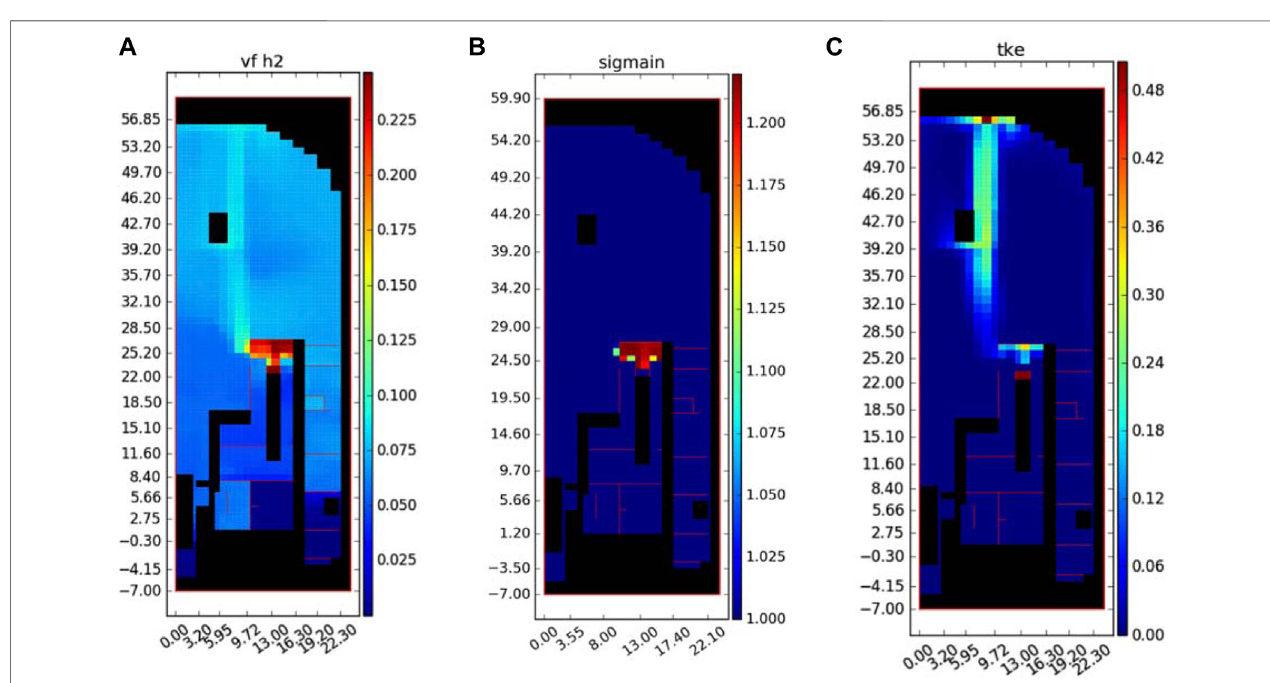
FIGURE 8 | Initial fl ow fi eld for the combustion analysis. (A) Hydrogen concentration. (B) σ Criterion. (C) Turbulent kinetic